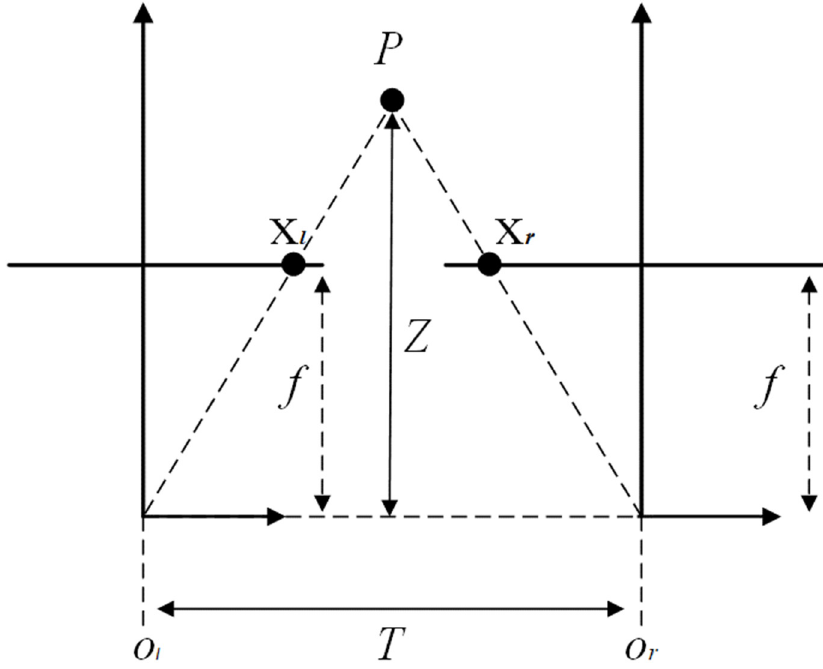
Figure 8. The principle of spatial measurement.